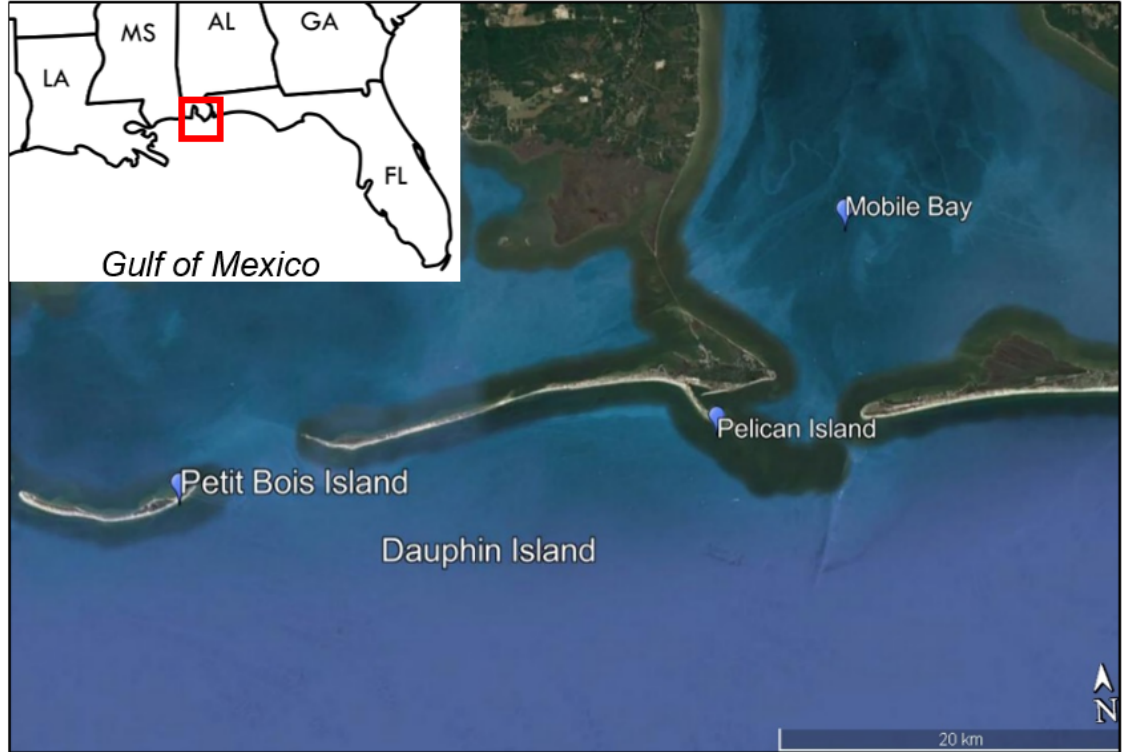
Figure 1. Study location; Dauphin Island, AL. (Created using Google Earth base map).